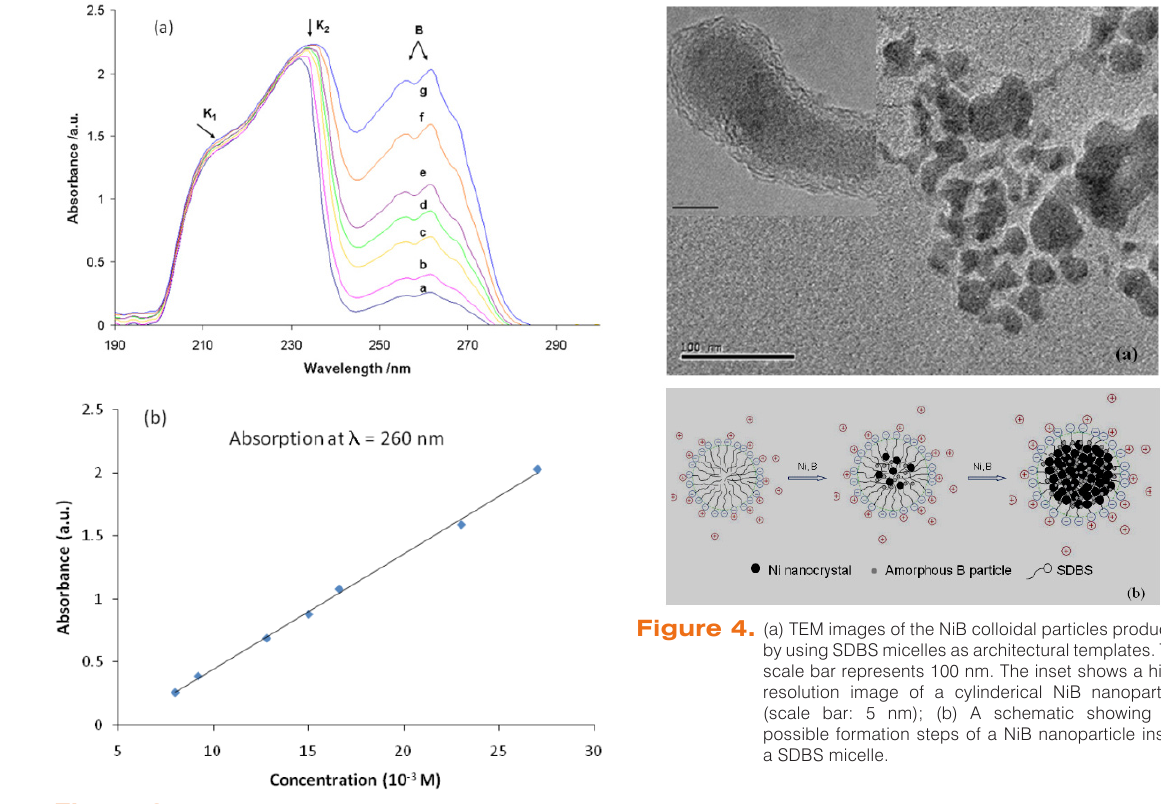
Figure 3. (a) UV-Vis spectra showing the absorption of SDBS in highly concentrated aqueous solutions; (b) A plot of the absorbance of the band at l = 260 nm against the solution concentration, corresponding to the spectrum of “a” to “g” shown in (a), with the concentration gradually increasing from 8.0×10 -3 to 2.7×10 -2 mol L -1 .